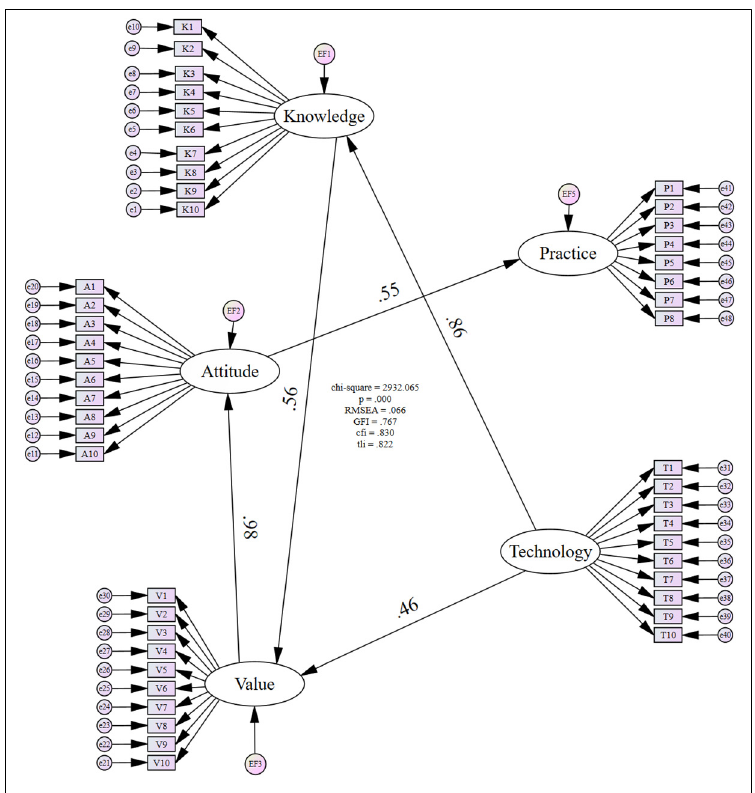
Figure 3. Screenshot of the Path Diagram from SPSS AMOS.